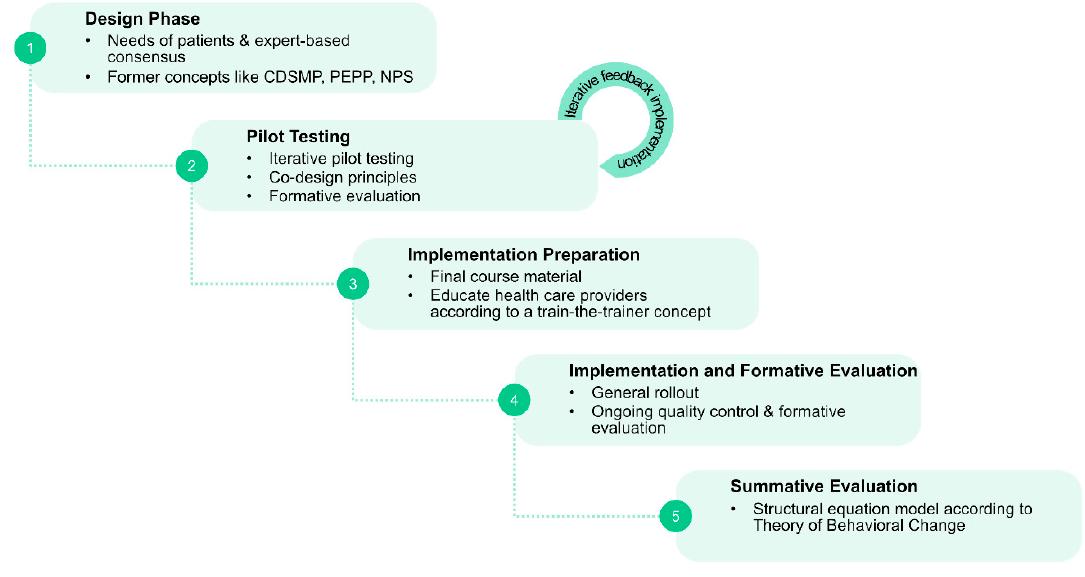
Figure 6. Sequential steps in phase 2.